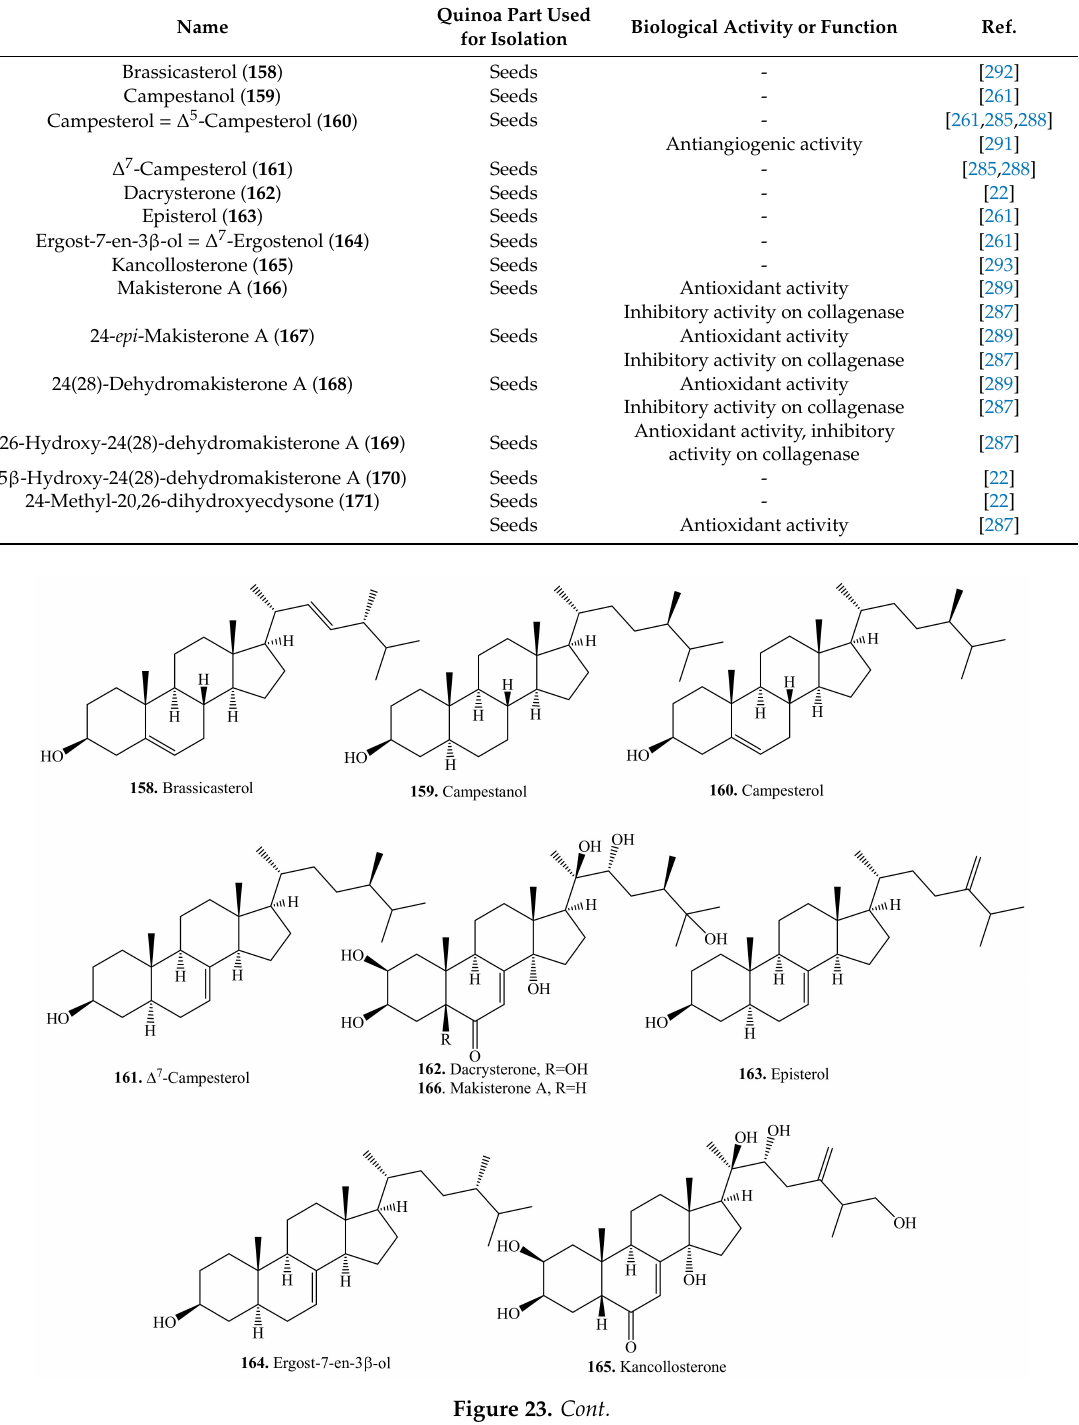
Table 20. C 28 -Steroids and their biological activities or functions.